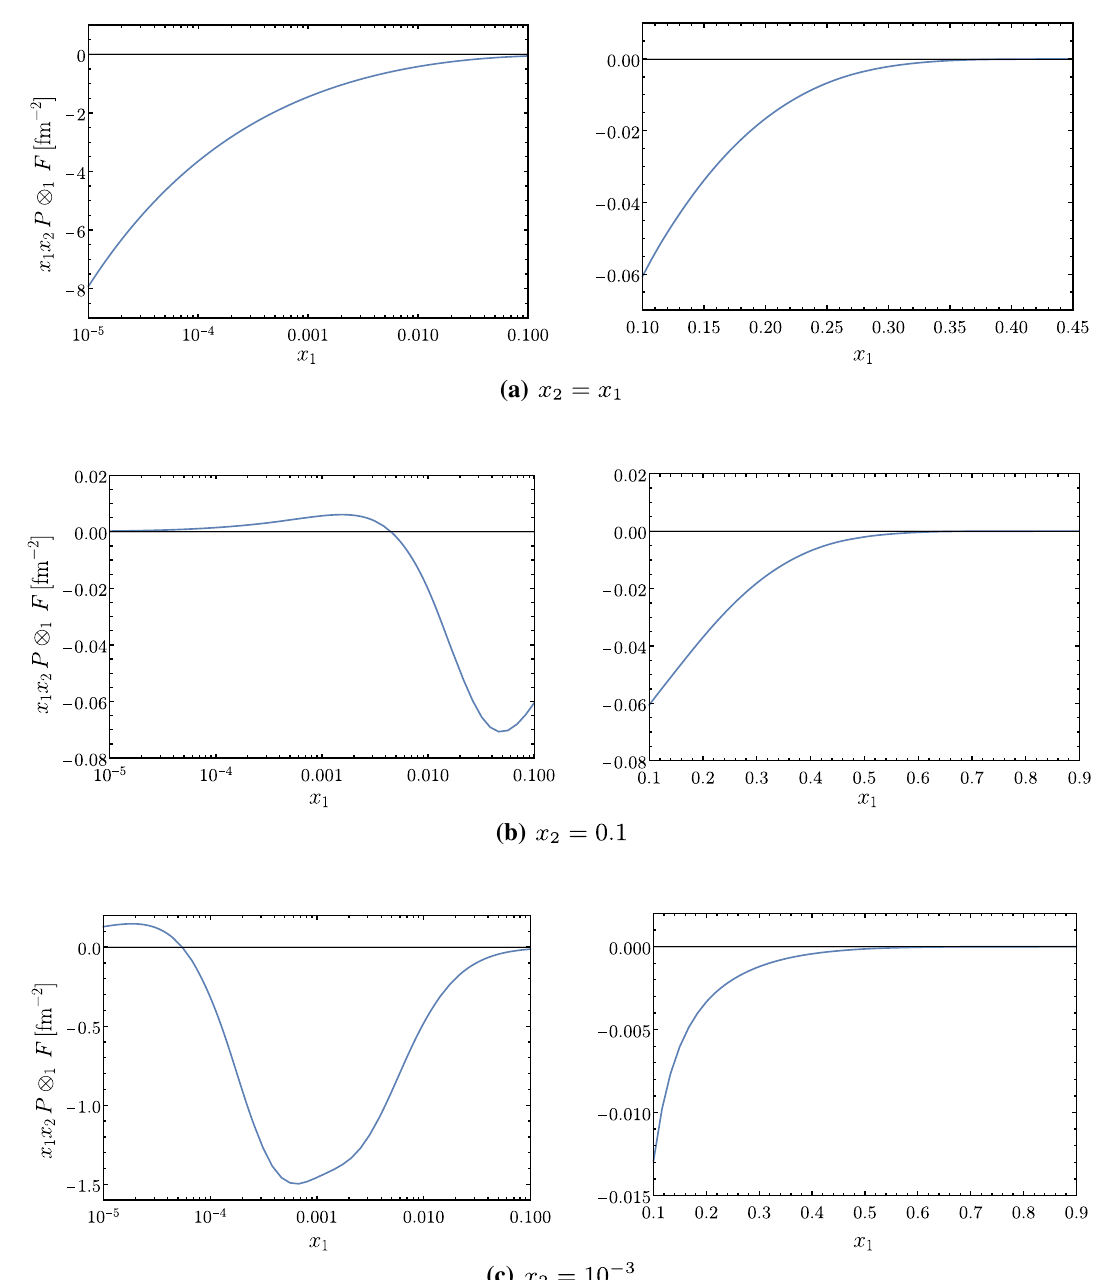
(μ) (cid:19) P ( z ) and 11 F s qq q ¯ q computed from the LO splitting formula